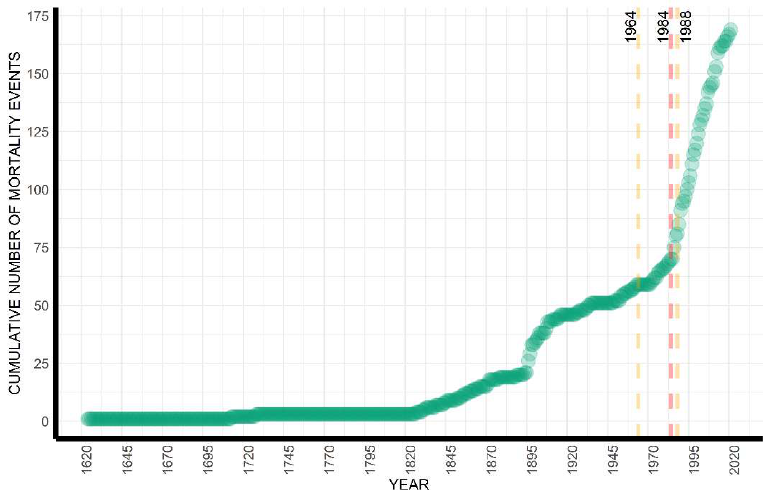
Figure 1. The cumulative number of mortality events between 1624 and 2021. Although the years 1624, 1713, and 1728 were highlighted as outliers in the time series and not included in the formal analysis, they are included here to depict the entire dataset. Dashed red lines represent the break- point in the time series and the dashed orange lines represent the breakpoint Lower and Upper Confidence Intervals.